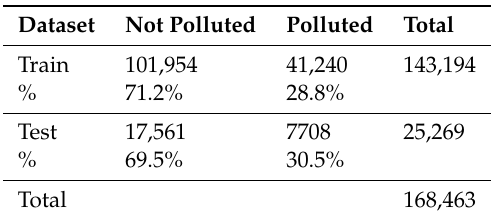
Table 3. Distribution of the dataset in 2 classes. Classes “very low” and “low” are collapsed into the “not polluted” class, and the remaining ones are collapsed into the “polluted”